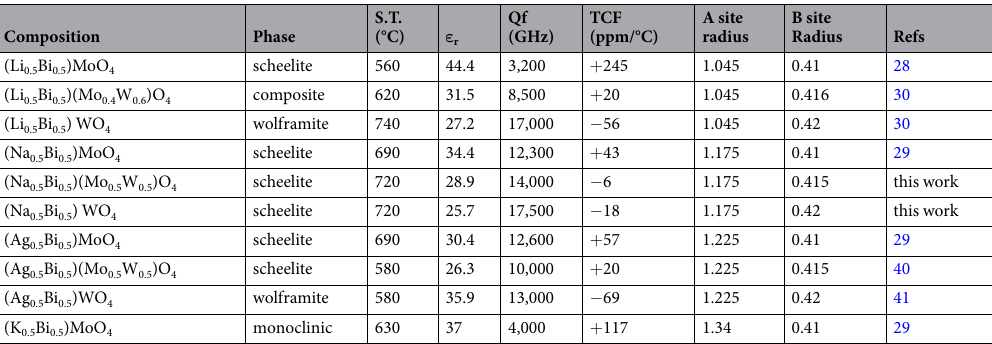
Table 2. Phase compositions, sintering temperatures (S. T.) and Microwave dielectric properties of the